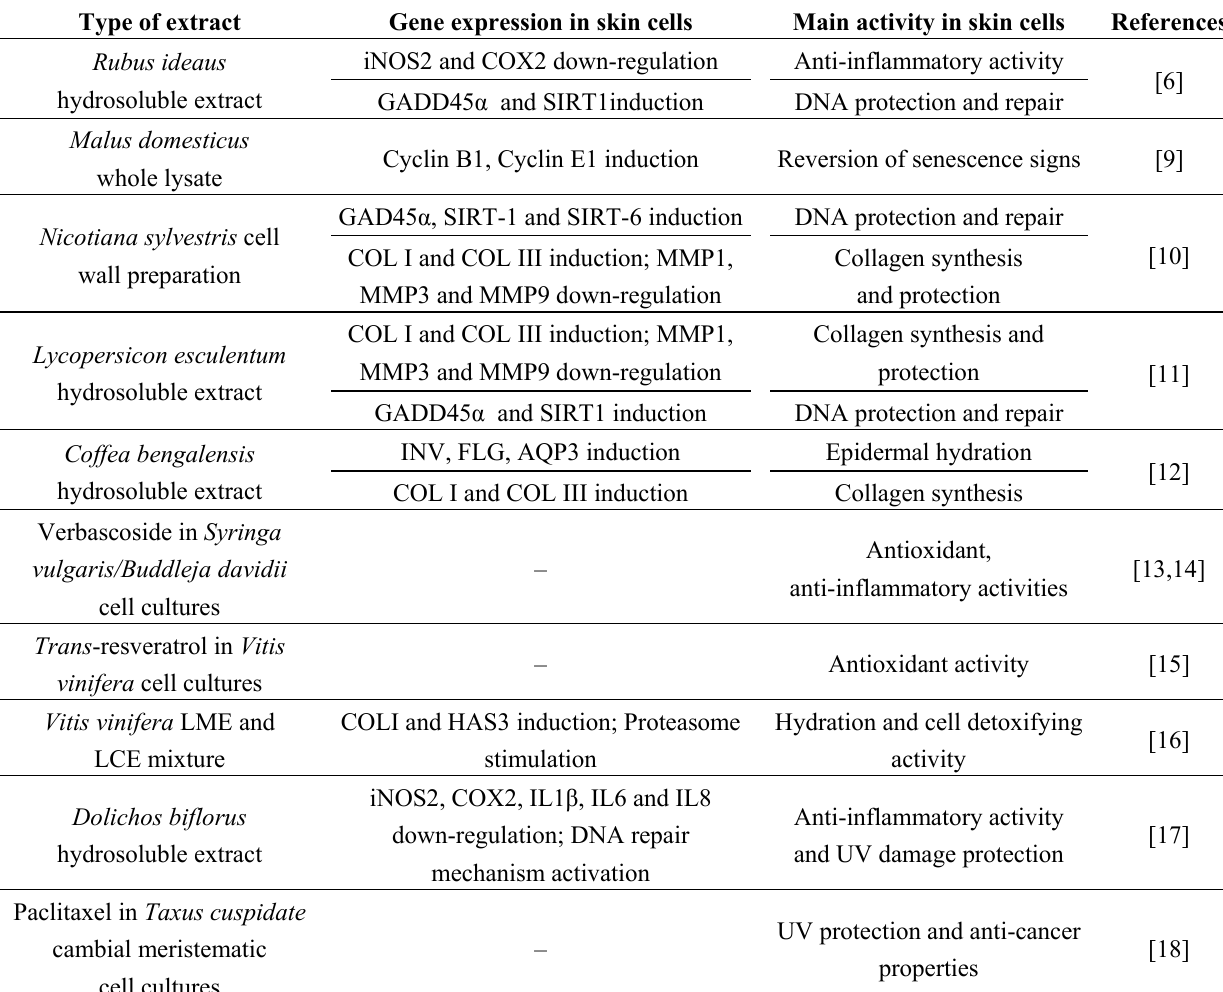
Table 1. Activities of the plant cell culture extracts and their main effects on gene expression in skin